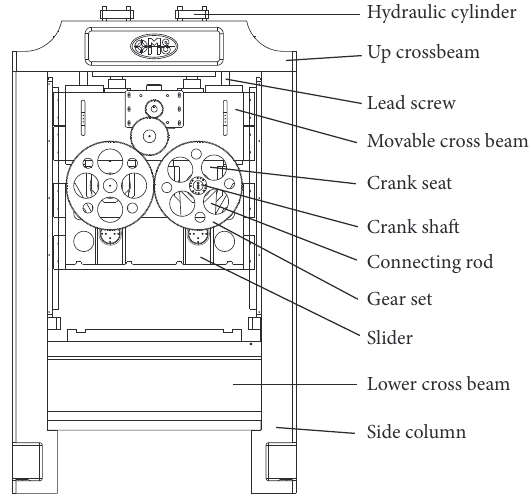
Figure 1: High-speed precision servo punching